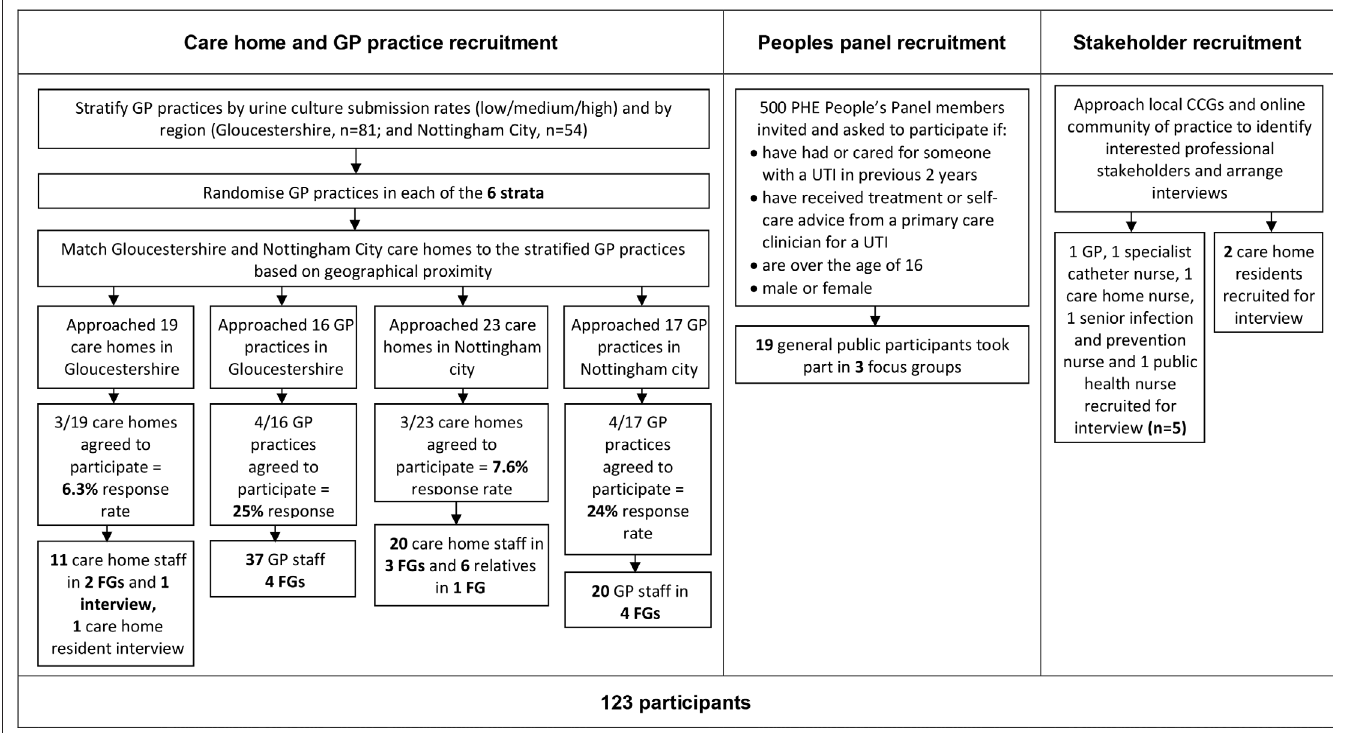
Figure 1 Recruitment flow chart. CCG = clinical commissioning group. FG = focus group. PHE = Public Health England. UTI = urinary tract